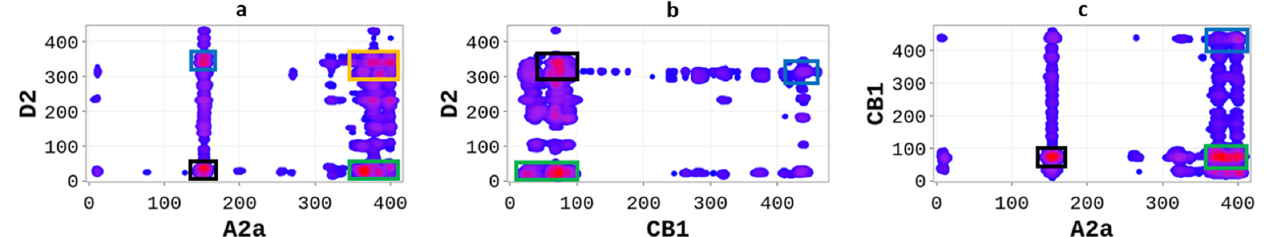
Figure 1. SP-DCA map using a total number of interacting aa, 𝑙 = 21 with optimized parameters 𝑎 = 𝑏 = 0.001 for A2aR/D2R ( a ), A2aR/CB1R ( b ), and CB1R/D2R ( c ). Amino acids are gradient color-coded: no interaction (white areas), medium interaction (blue), and highest probability of interaction (red spots). The rectangles delimit each heterodimer’s most likely interacting peptides (see text). Table 1. Summary of the SP-DCA predicted and previous evidence of interactions between selected GPCRs complexes and peptides selected for molecular dynamic simulations Predicted Interactions Peptides Selected for MD (SP-DCA)